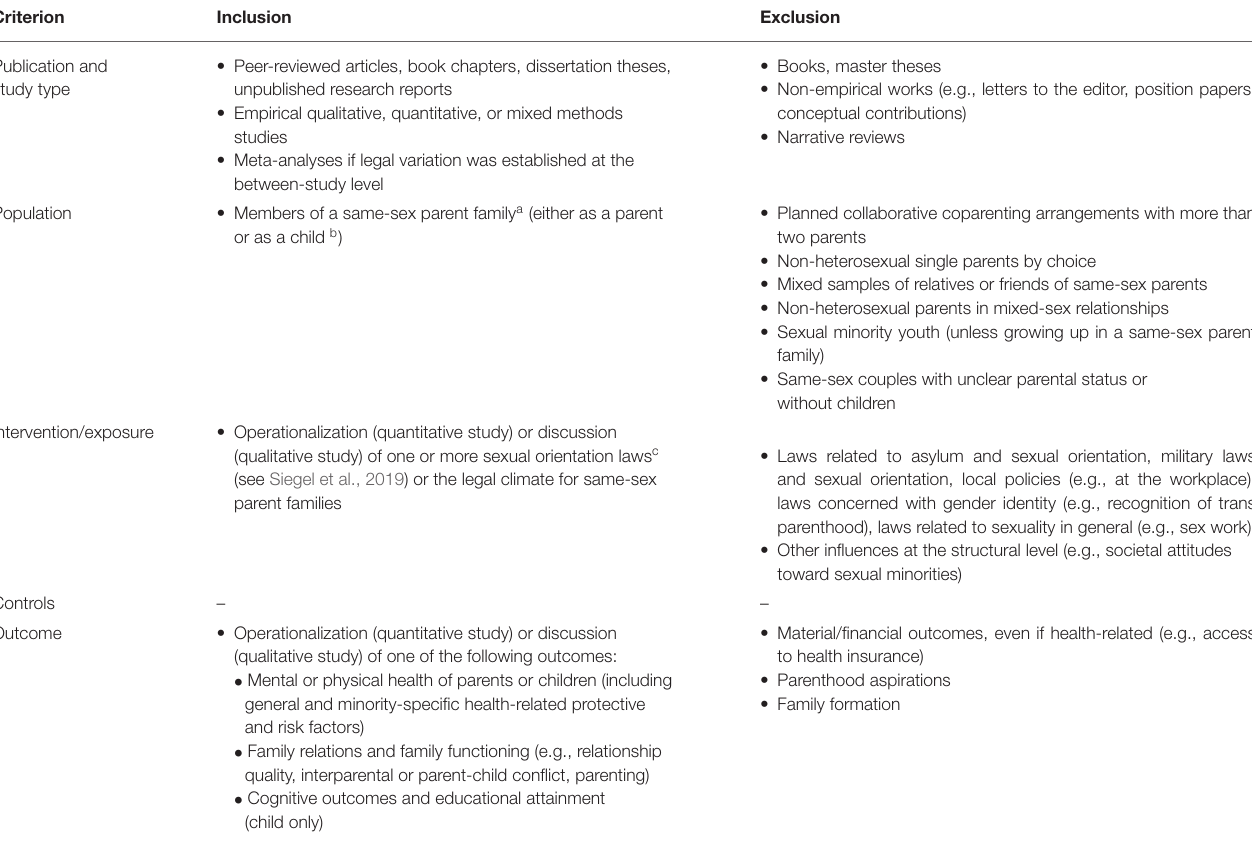
TABLE 1 | Inclusion and exclusion criteria according to population, intervention/exposure, controls, outcome, study type (PICOS).